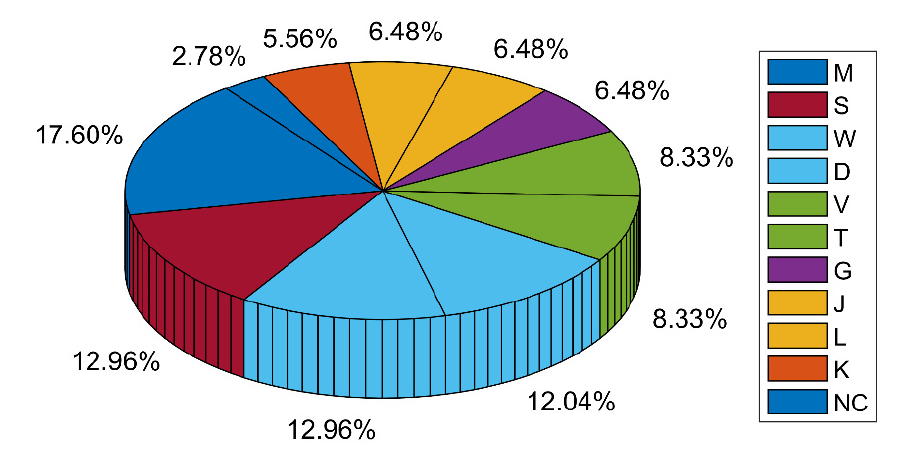
Figure 5. Frequency diagram of failure parts of machining center. Table 2. Failure modes frequency table of the machining center.